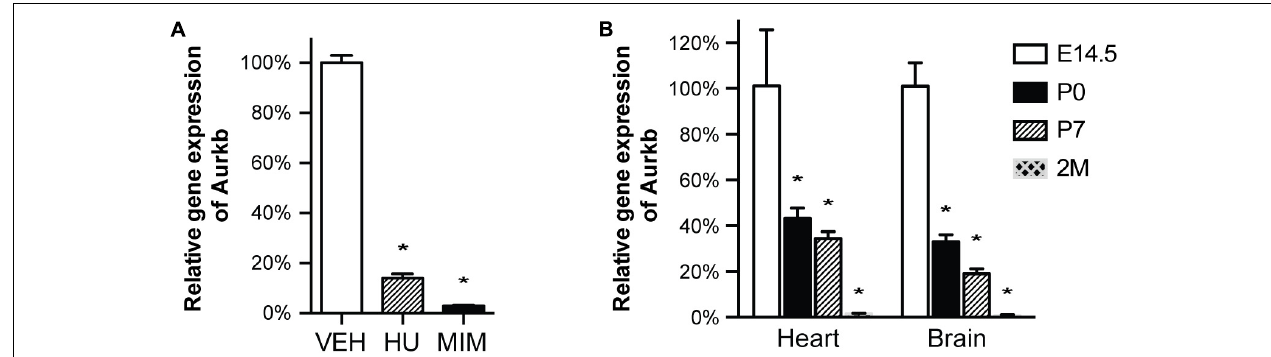
FIGURE 3 | Aurkb gene targeting. (A) Schematic of the generation of the Aurkb ER Cre allele; (B) Southern blot of DNA extracted from Aurkb ER Cre / + MEFs. DNAs were digested by Eco RV (RV). The 32 P-radiolabeled 5 (cid:48) DNA probe used ( ∼ 500 bp) is located upstream of the 5 (cid:48) arm but downstream to the 5 (cid:48) RV enzyme site. P1F, P1R, P2F, and P2R are primer sets for detecting Aurkb transcripts; (C) Aurkb mRNA expression in wildtype (WT) and heterozygous (HET) E12.5 embryos. n = 4 in each group. *** P < 0.001 by a Student’s t -test; (D) Aurkb protein expression in WT and HET E12.5 embryos. GAPDH was used as a protein loading control. Densitometric quantification of Aurkb was shown on the right. N.S., not significant.